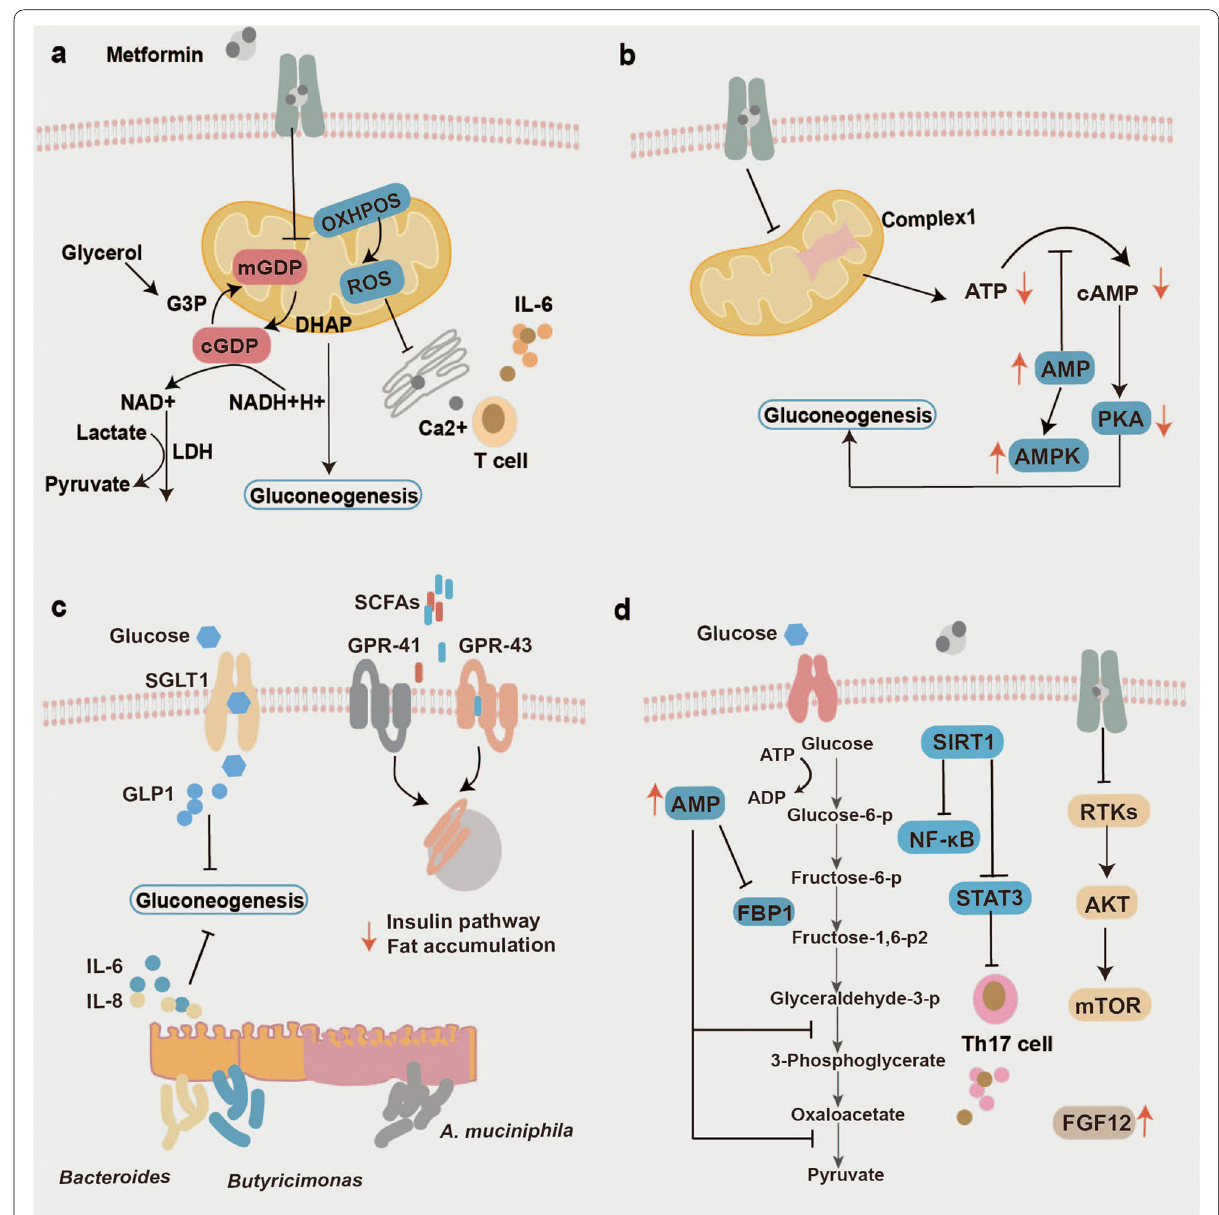
Fig. 3 AMPK‑independent mechanisms of action mediated by metformin treatment. a Metformin‑induced restoration of redox balance. b Metformin‑induced changes in mitochondria. c Metformin‑induced modulation of gut microbiome. d metformin‑induced regulation of signals, including FBP1, PP2A, FGF21, SIRT1 and